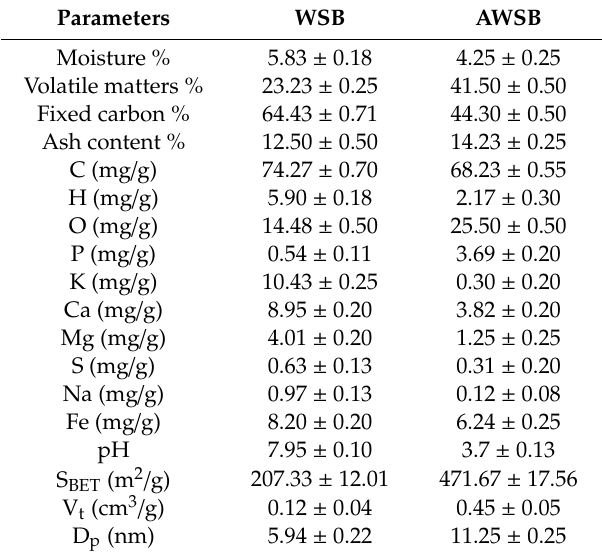
Table 1. Various properties of wheat straw biochar (WSB) and acid wheat straw biochar